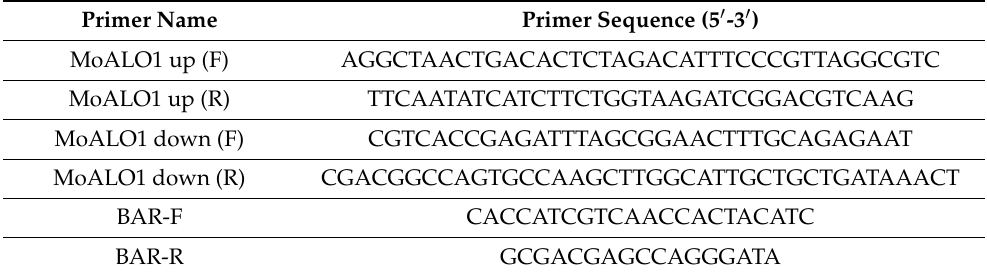
Table A1. The primers used in this